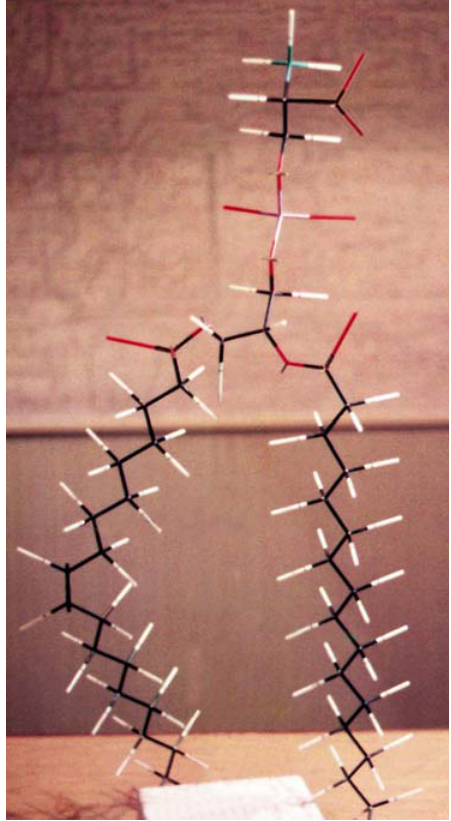
Figure 1. A “skeleton” model of 1-palmitoyl-2-oleoyl-SN-glycero-3-phospho- L -serine built by the first author in 1981. The carbon tail on the right is shown